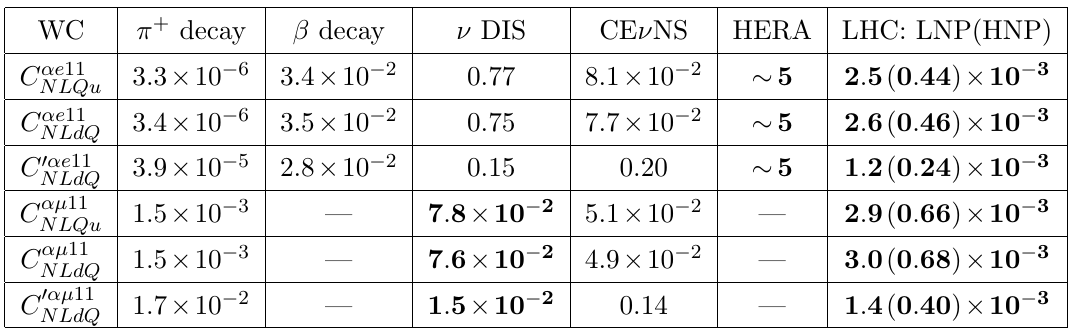
Table 3. Current 90% C.L. bounds on the three SMNEFT WCs C NLQu , C NLdQ , and C 0 the electron and muon (cid:13)avors at a 1 TeV energy scale. The constraints obtained by allowing all WCs to simultaneously vary are in